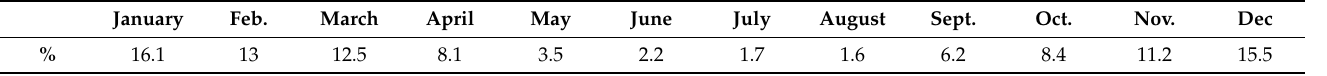
Table 2. Monthly distribution of consumption of gas used for heating and heating oil.